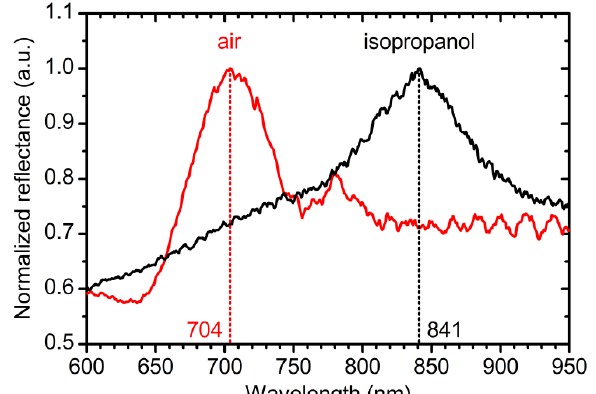
Figure 8. Refractive index sensor ability of the anodic titanium oxide (ATO) photonic crystals. Reflectance spectra of PC_8 with pores filled with air (red line) and isopropanol (black line). Parameters of the synthesis: t 0 = 150 min; L total = 21,000 nm; L 0 = 350 nm.